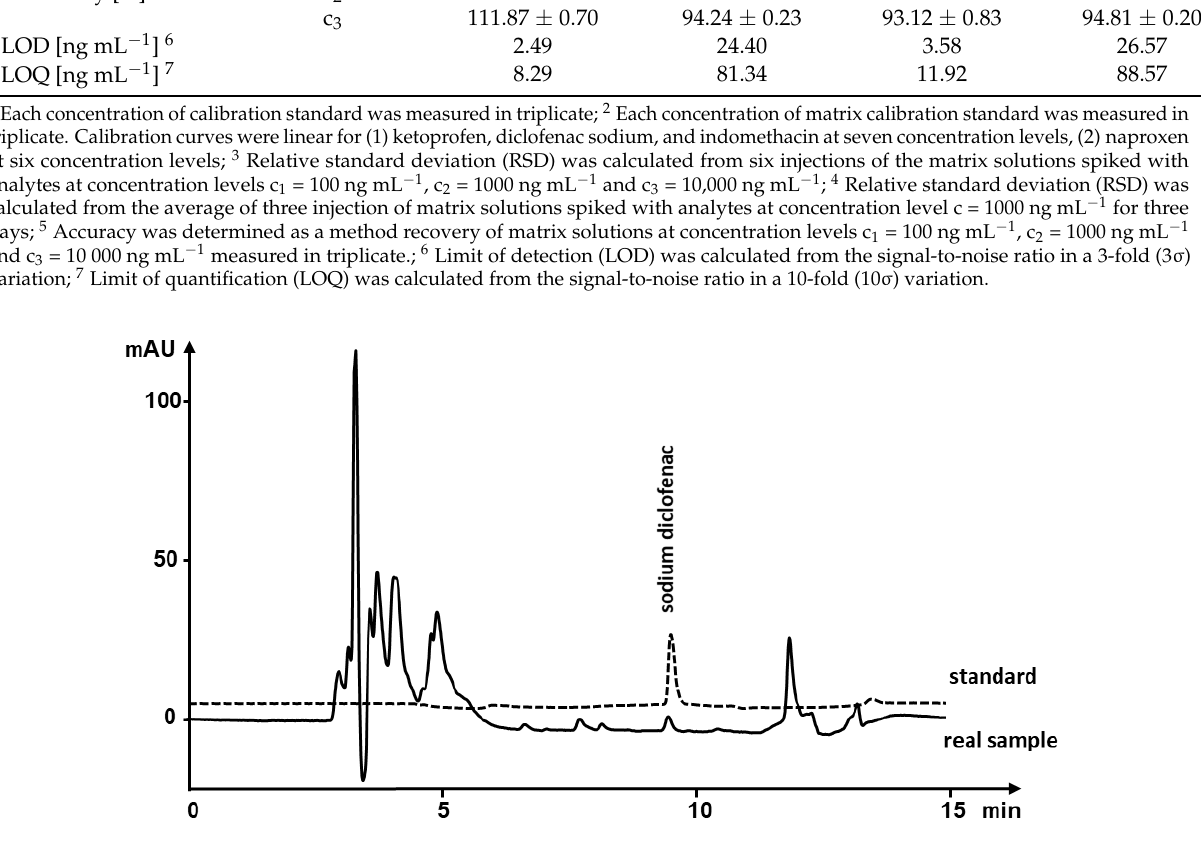
Figure 5. Standard solution spiked with 50 ng mL − 1 diclofenac and real patient human serum containing the same drug. The concentration of diclofenac in real sample was equal to 32.57 ng mL − 1 in ten times diluted serum.